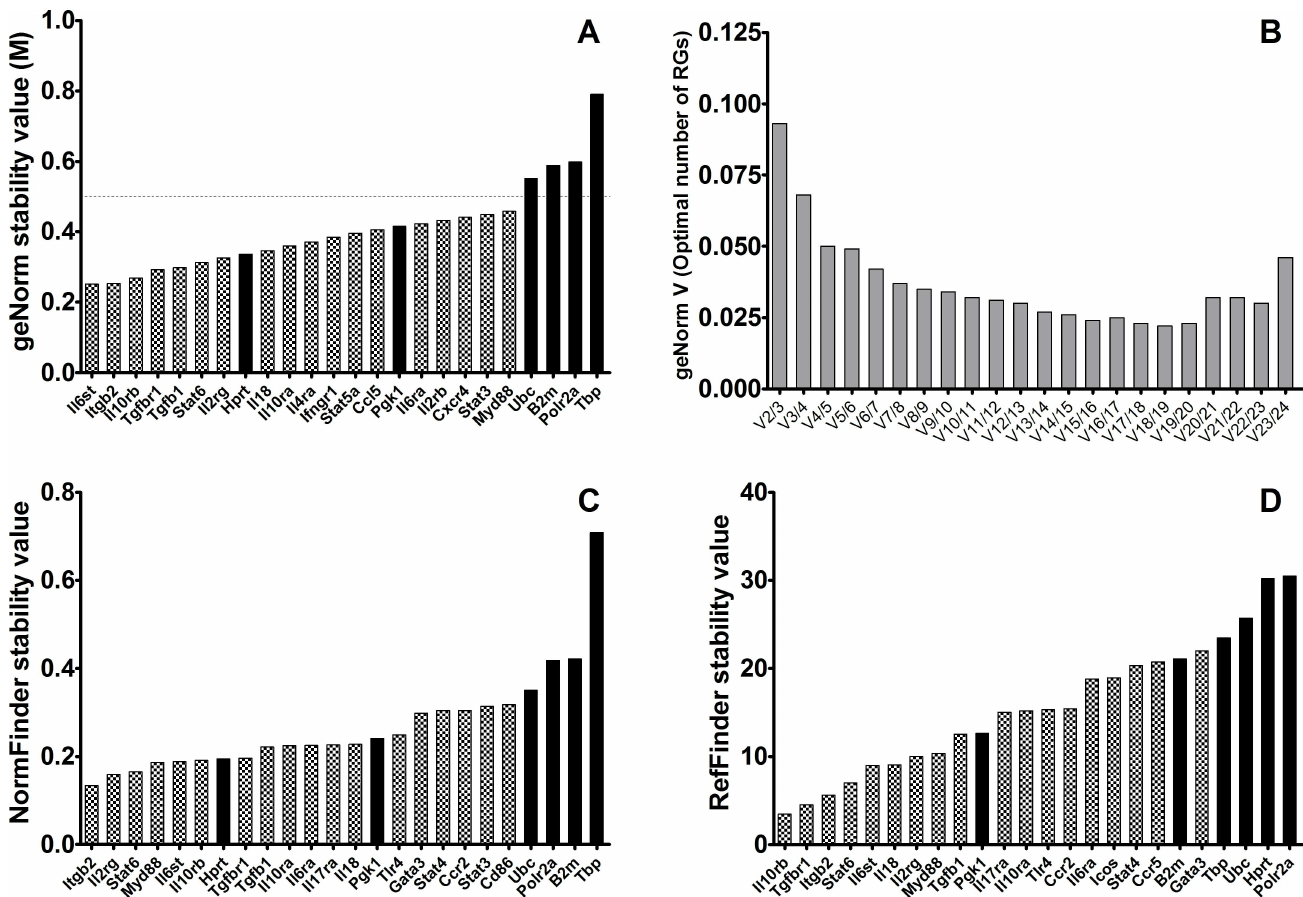
Fig 2. Stabilityvalues of the best candidate reference genes(lightgray) and 6 six classicalreferencegenes(black bars) in spleensamplesof Leishmania -infectedBALB/c mice.A) M-stability value accordingto geNorm;horizontalline marksthe thresholdstabilityvalue M = 0.5. B) Pairwise variation( V n/n+1 ) between the normalizationfactors of the samples according to geNorm. C) Stabilityranking according to NormFinder. D) Stability ranking according to RefFinder. Lower values indicatehigherstabilityfor all rankings.